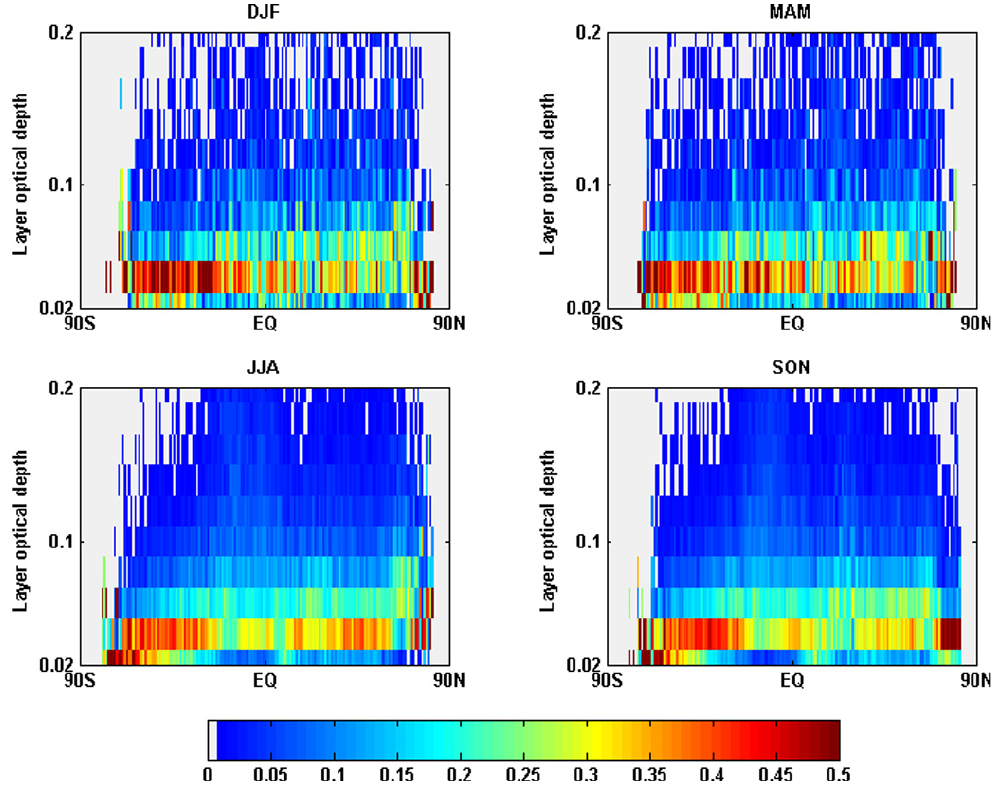
Fig. 6. The zonal seasonal distribution of optical depths of the overlying aerosol layers for the AAO case. Each bin in is 0.02 optical depth units by one degree latitude. Each optical depth bin along y-axis is normalized by the total number of observations at a particular latitude